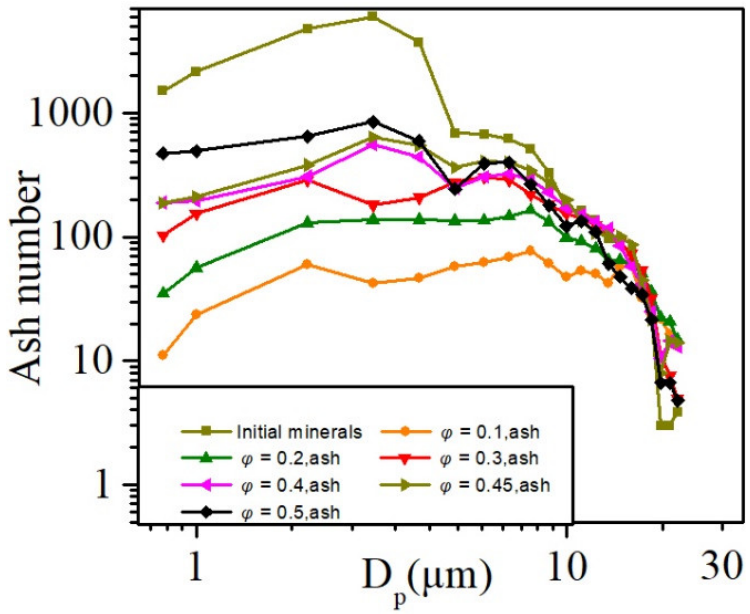
Figure 10. Particle number size distribution.